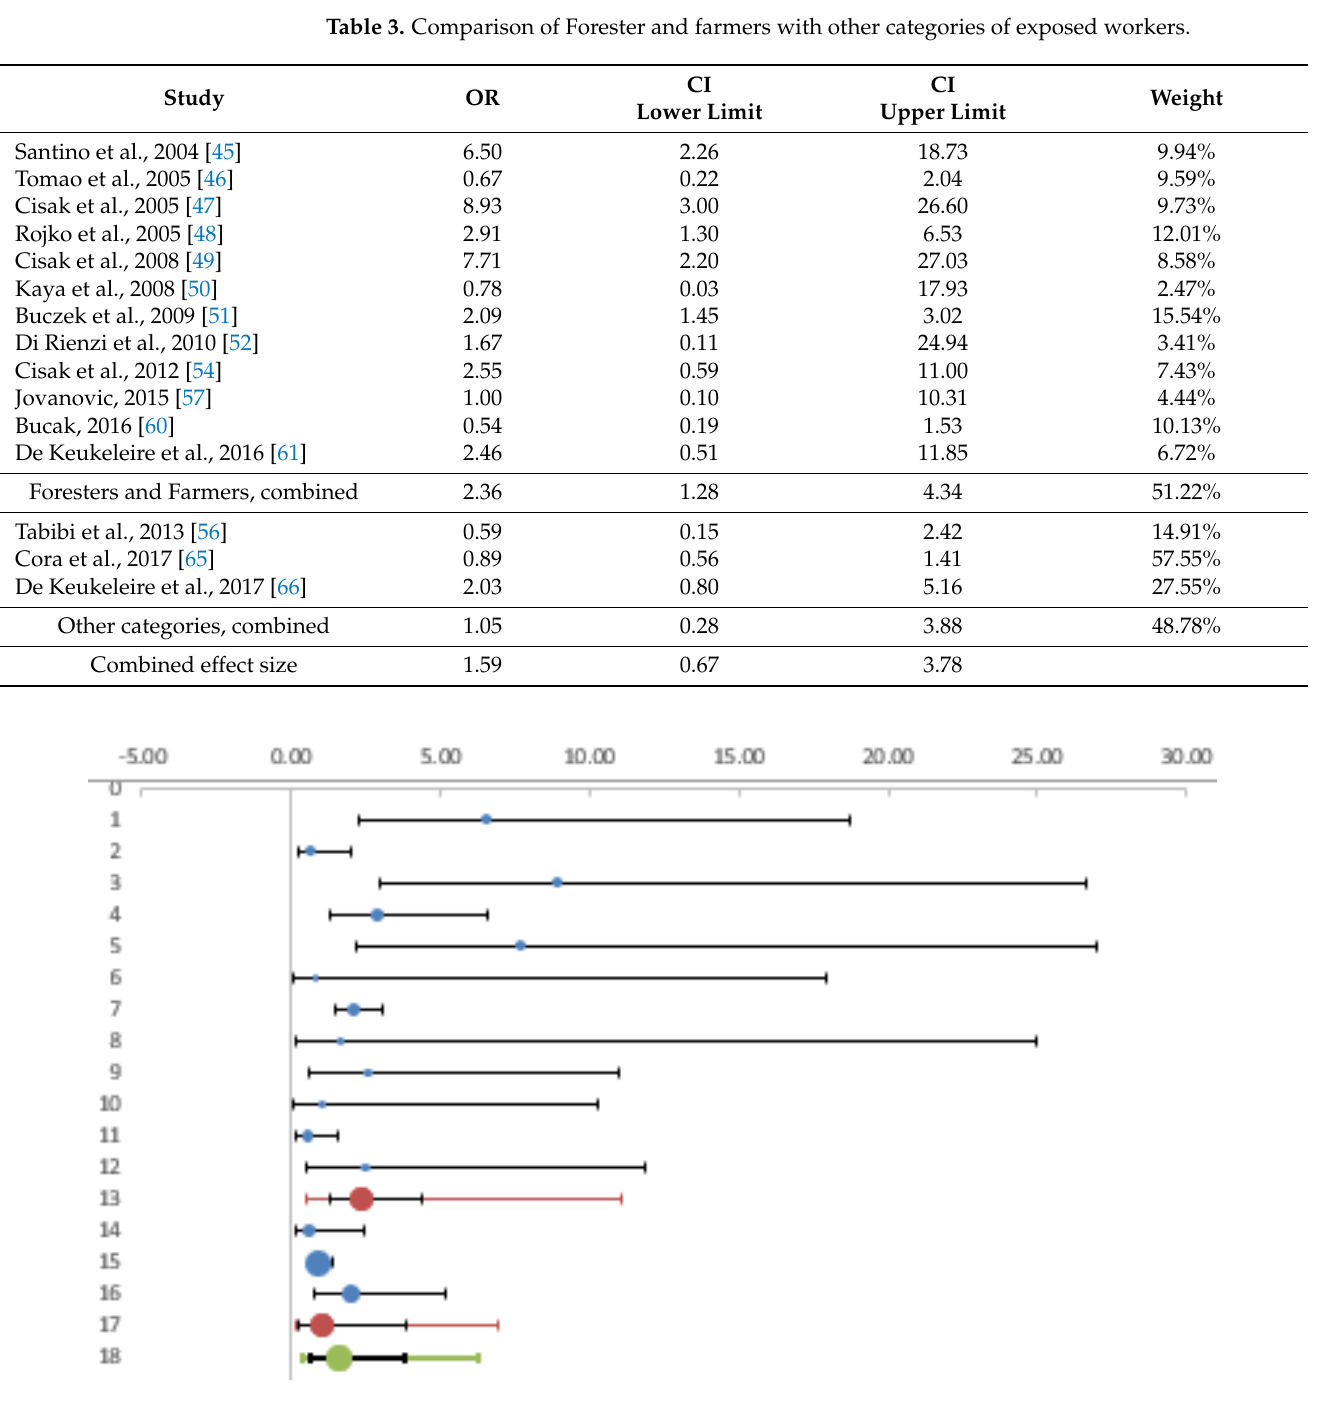
Figure 4. Forest plot. Foresters and farmers compared with other categories of workers.